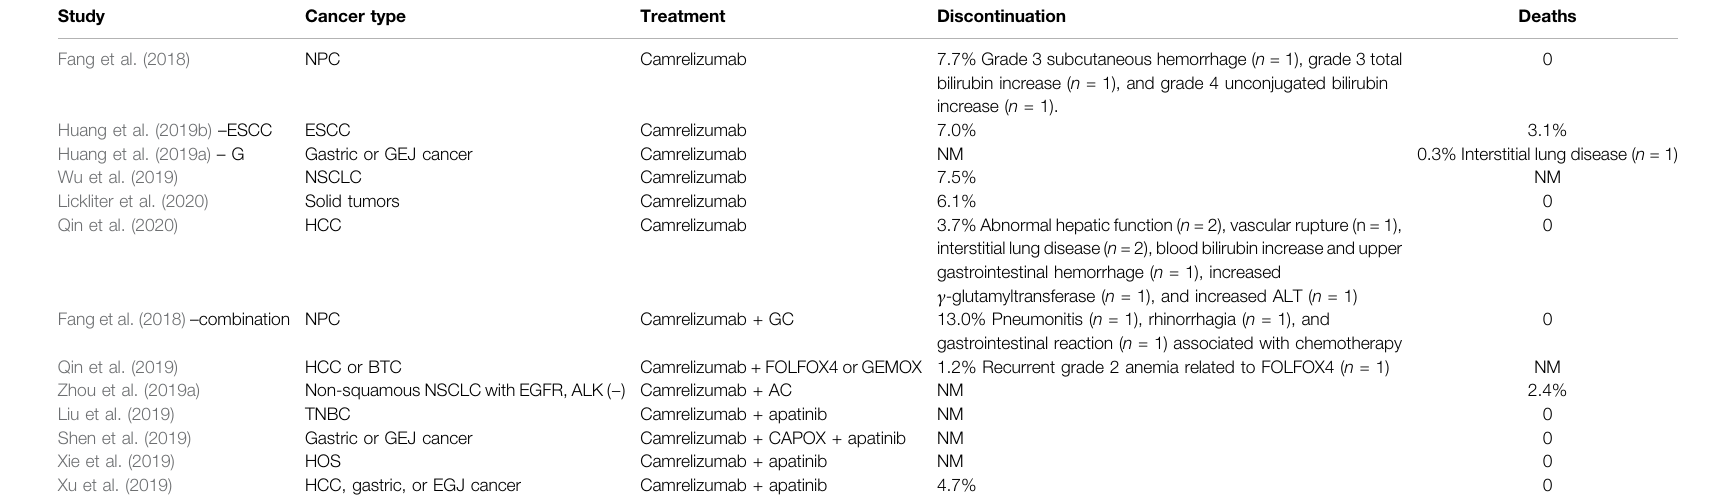
TABLE 3 | AEs leading to therapy discontinuation and